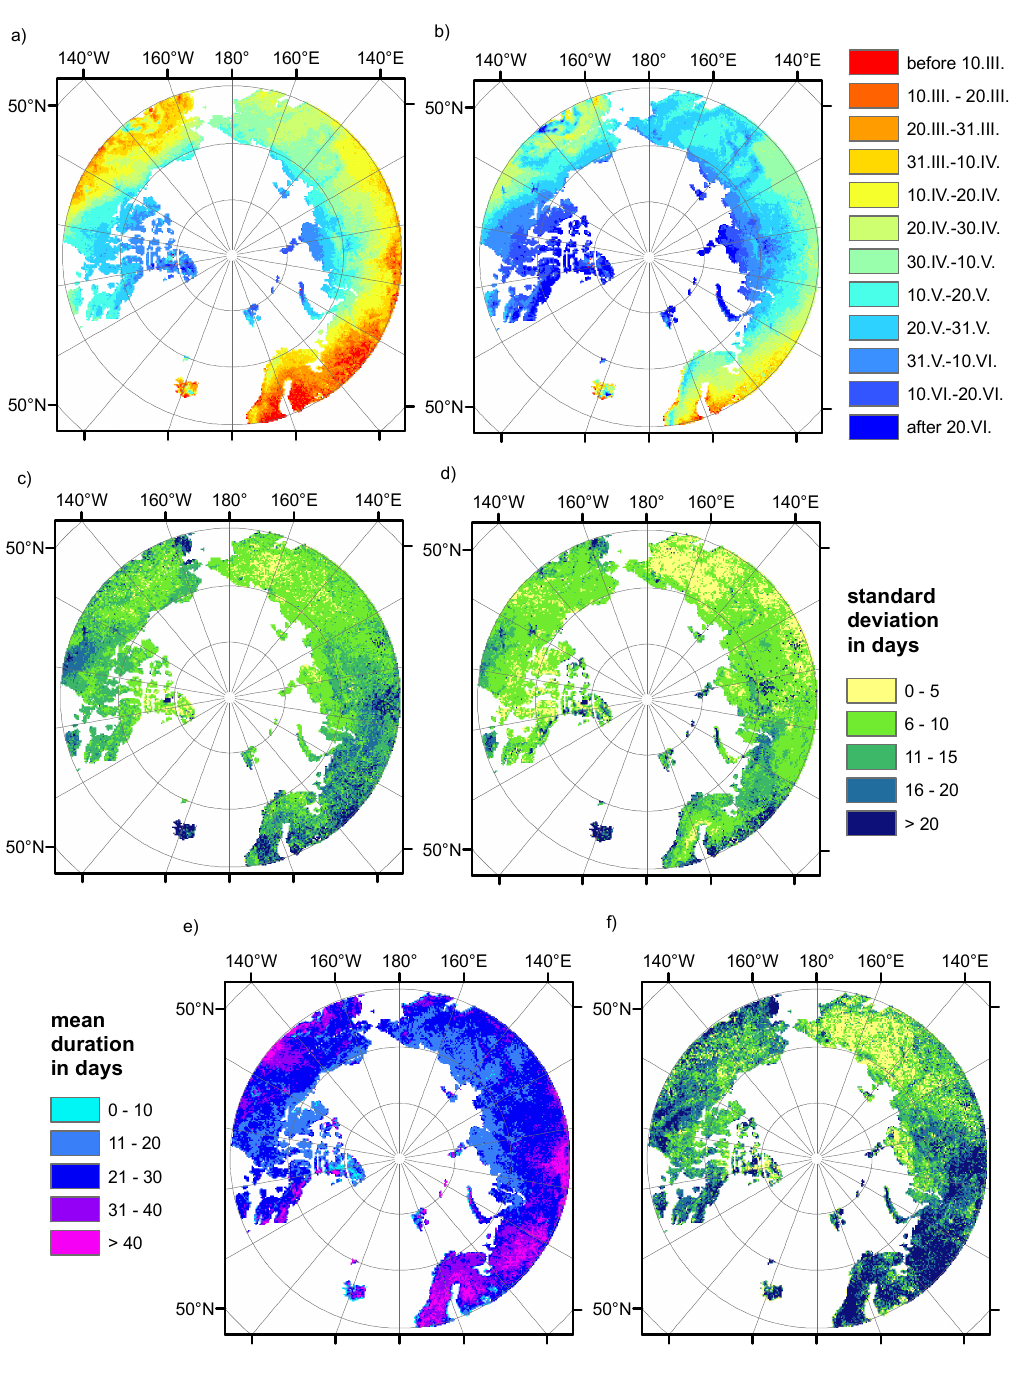
Figure 4. Ten years (2000–2009) of spring snow melt dynamics based on diurnal thaw and refreeze detection [12]: (a) mean day of snowmelt start, (b) mean day of snowmelt end, (c) standard deviation of start of snowmelt in days, (d) standard deviation of end of snowmelt in days, (e) mean duration of spring snowmelt period, (f) standard deviation of spring snowmelt